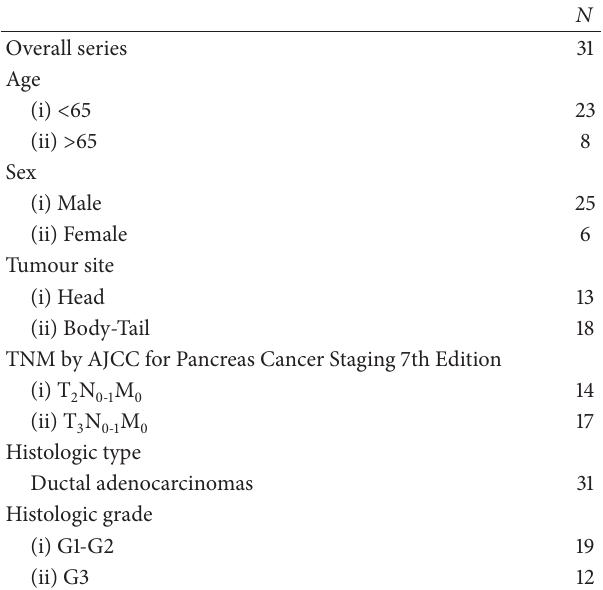
Table 1: Clinicopathological features of